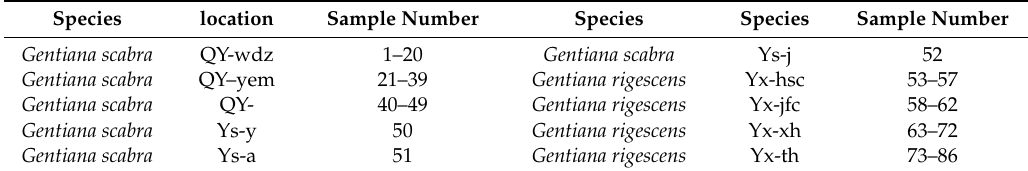
Table 3. Sample collection information of